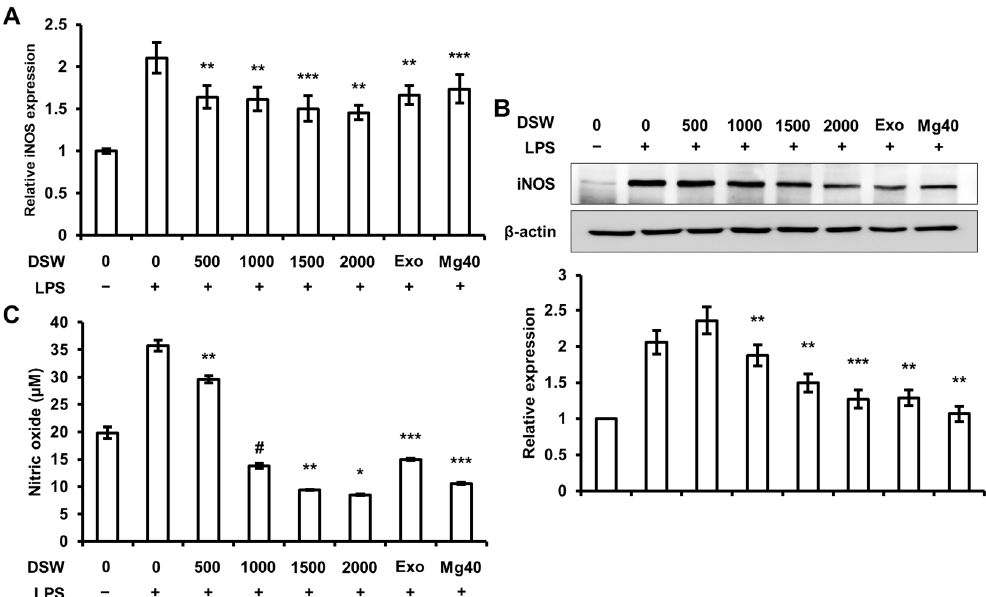
Figure 2. Effect of RDSW on LPS-stimulated iNOS expressions and NO production. Effect of RDSW on LPS-induced ( A ) mRNA and ( B ) protein expressions of iNOS in RAW 264.7 macrophage cells. ( A ) Glyceraldehyde 3-phosphate dehydrogenase (GAPDH) was used as an internal control; ( B ) band density was normalized with β -actin; ( C ) The production of NO was measured in a conditioned medium of cells pre-treated with RDSW for 24 h prior to the stimulation of 1 µg/mL LPS for 24 h. The amount of NO presented as nitrite in the medium was measured by Griess reagent and normalized with the amount of total protein in each sample. All experiments were performed in triplicate, and all data are shown as the mean ± SD. * p < 0.05, ** p < 0.01, *** p < 0.001 and # p < 0.0001 compared to the LPS-induced control. Exo: hardness 1500 of exogenous Mg and Ca mixture, Mg:Ca = 3.5:1; Mg40: hardness 1500 of high Mg DSW, Mg:Ca = 40:1.